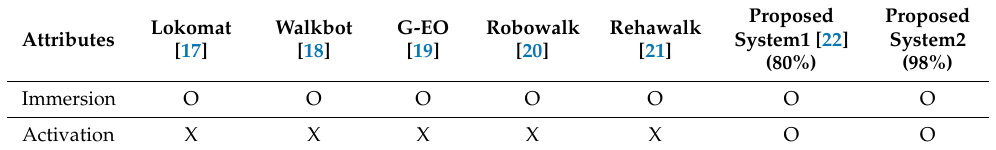
Table 1. Comparison of existing and proposed systems .